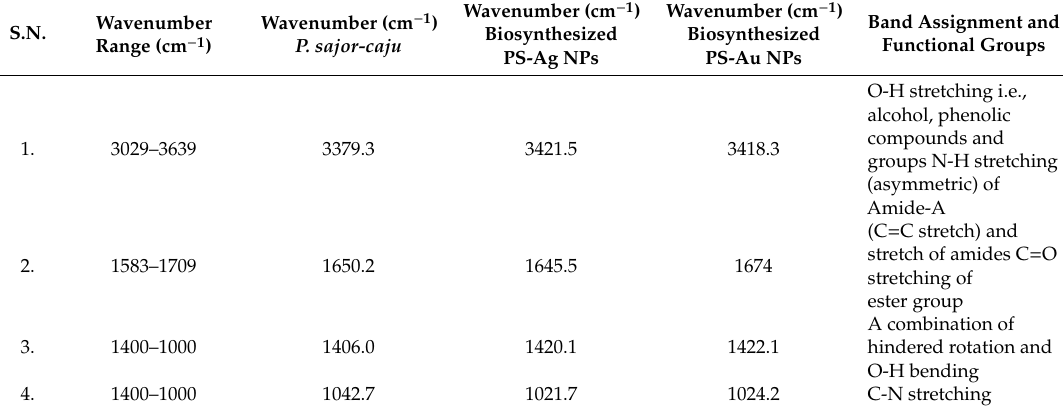
Table 2. Functional groups associated with significant vibration bands in the mid-IR spectrum of P. sajor-caju , biosynthesized Ag NPs and Au NPs.